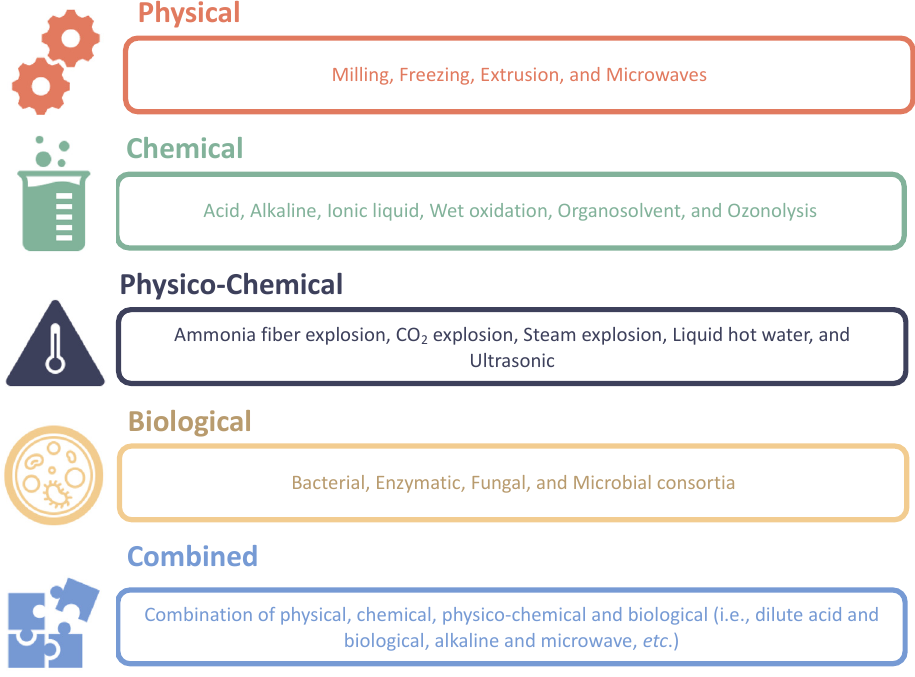
Figure 3. Types and examples of pre-treatment methods.